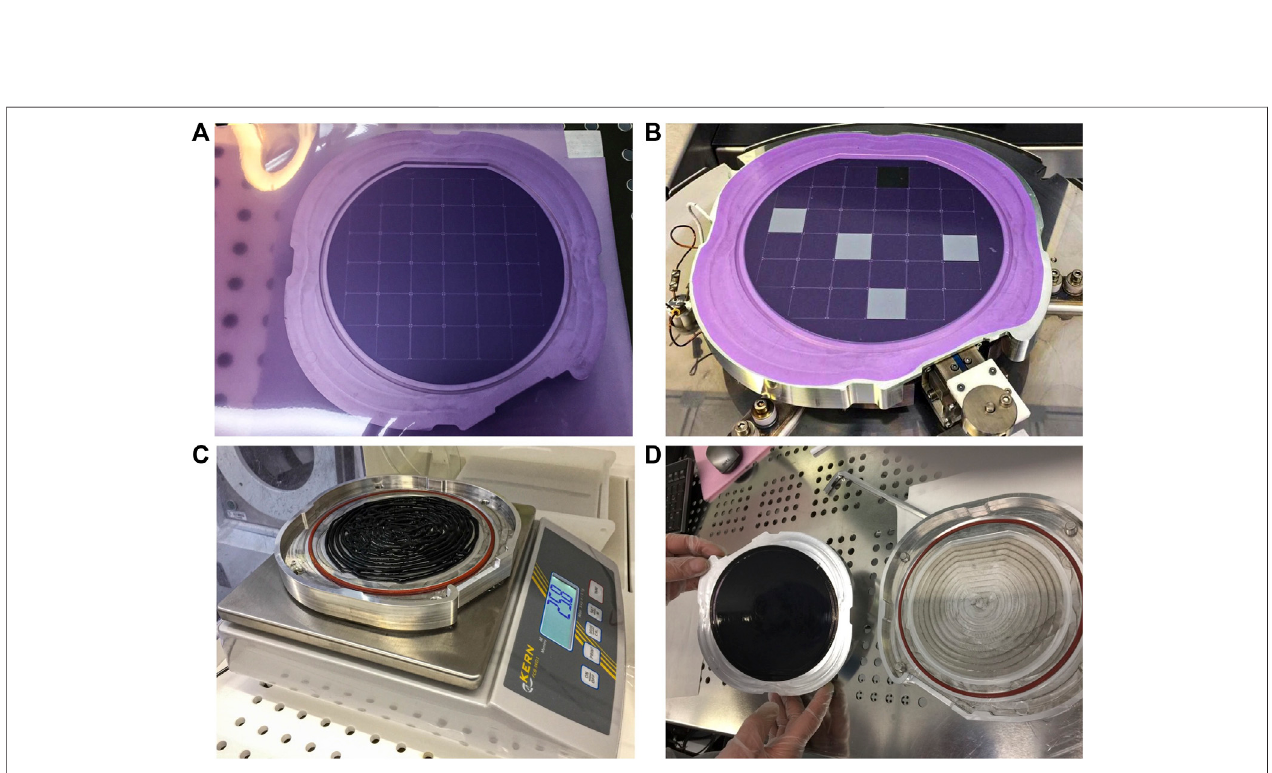
FIGURE3|(A) laminationofthesupportwaferwiththebonding fi lm; (B) fourdiesplacedoncarrierwaferwith fl ip-chipmachine; (C) epoxydepositedinthebottom mold shell and weighting; (D) opened mold at the end of the process with the WLP to be extracted from the upper mold shell.